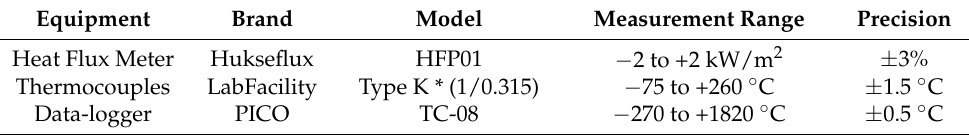
Table 2. Features of the measurement equipment used in the lab experiments.